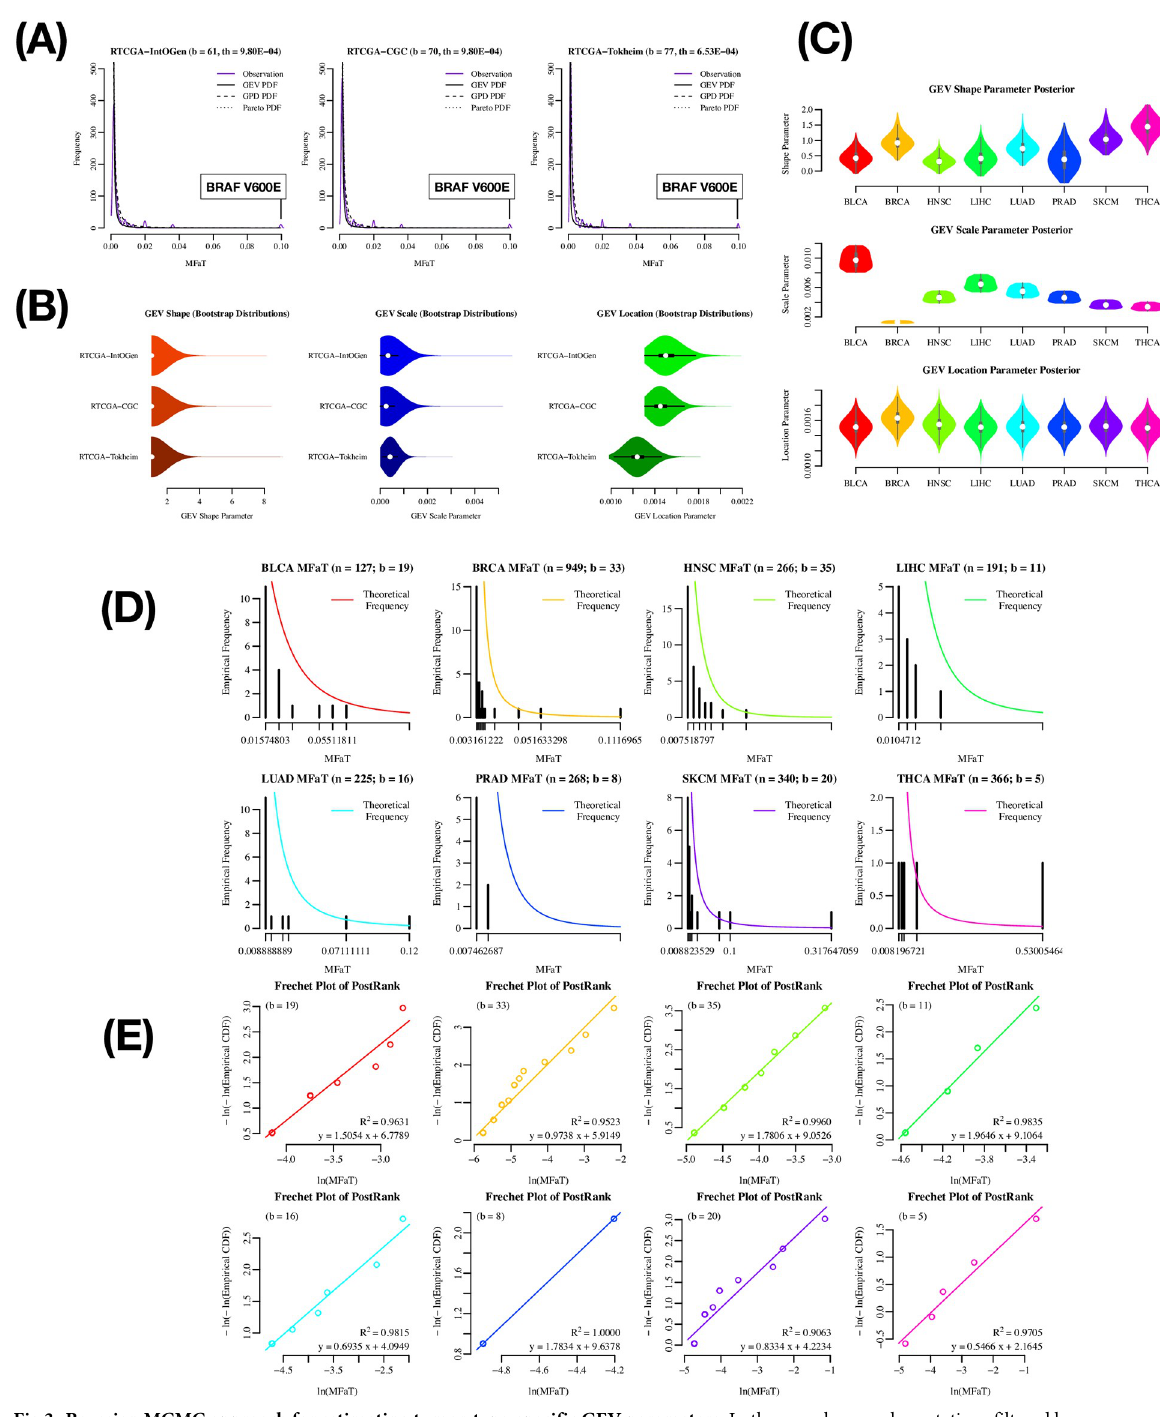
Fig 3. Bayesian MCMC approach for estimating tumor-type-specific GEV parameters. In these analyses, only mutations filtered by gene symbols are analyzed (i.e., symbol-based filtering). In the total-tumor analysis, we used the IntOgen, CGC, and Tokheim driver-gene definitions, and in the case of tumor-type-specific analyses, we used only the IntOgen definition. (A) Density plot of MFaTs in the cases of the RTCGA total- tumor with symbol-based filtering. The colored solid line is the probability density of observations, the black solid line is the probability density function (PDF) of GEV, and the dotted lines are the PDFs of the GPD and Pareto distributions, respectively. For each plot, a gene symbol and an amino acid substitution of a mutation with the highest MFaT value is shown in a box. Here, “b” denotes the number of genomic sites of beneficial mutations considered, and “th” denotes the effective threshold against MFaTs when selecting mutations according to ranks (for details, see Materials and methods). (B) Bootstrap distributions of GEV parameters in the total-tumor analysis. We used the maximum likelihood method for